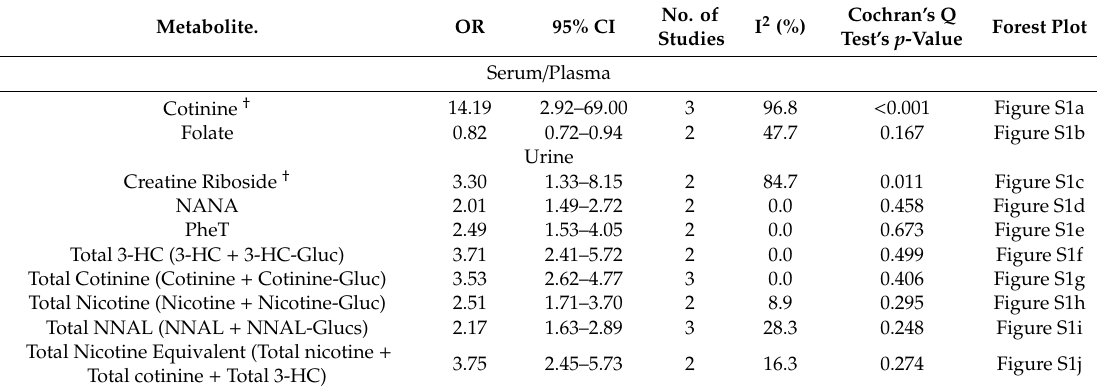
Table 3. Odds ratio (OR) and 95% confidence interval (CI) of the association of lung cancer in relation to metabolites that achieved statistical significance. Refer to Figure S1 for the forest plot of each metabolite.